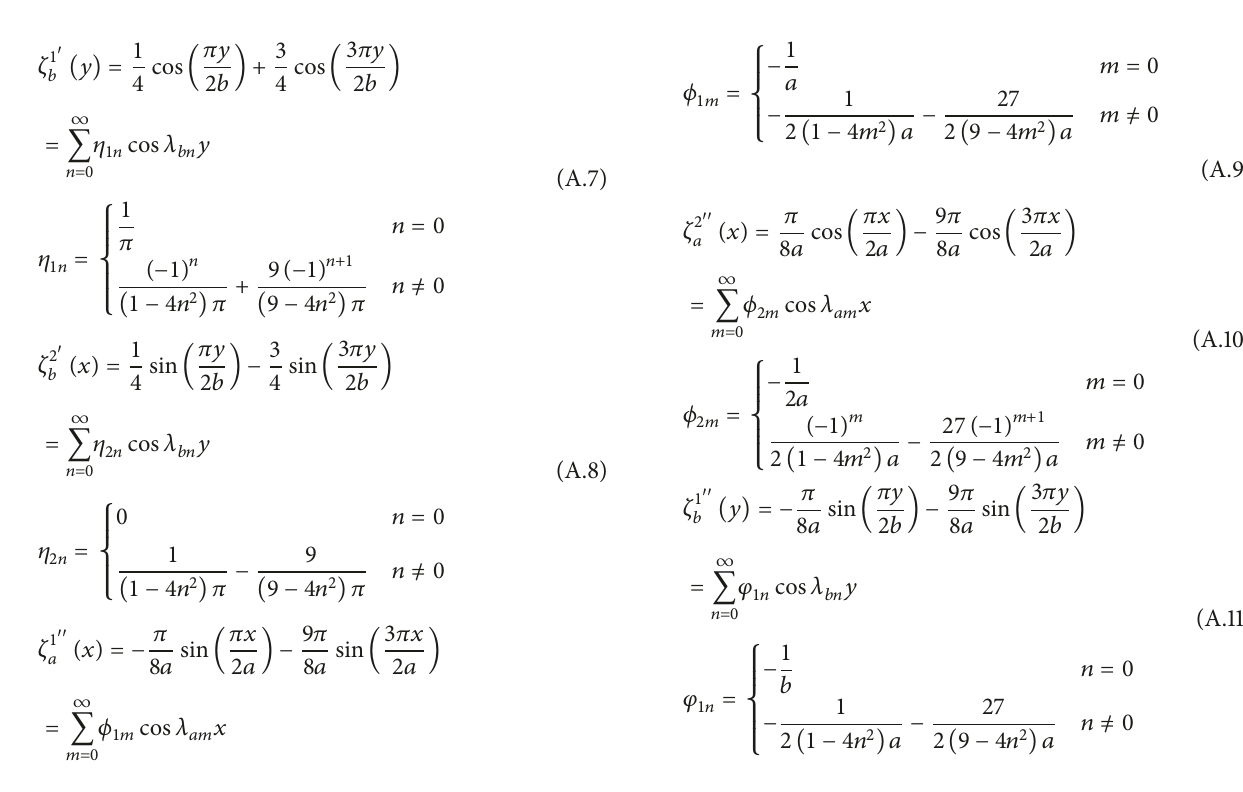
Figure 10: The first six mode shapes of square rectangular plates with uniform completely clamped boundary conditions, calculated by FEA